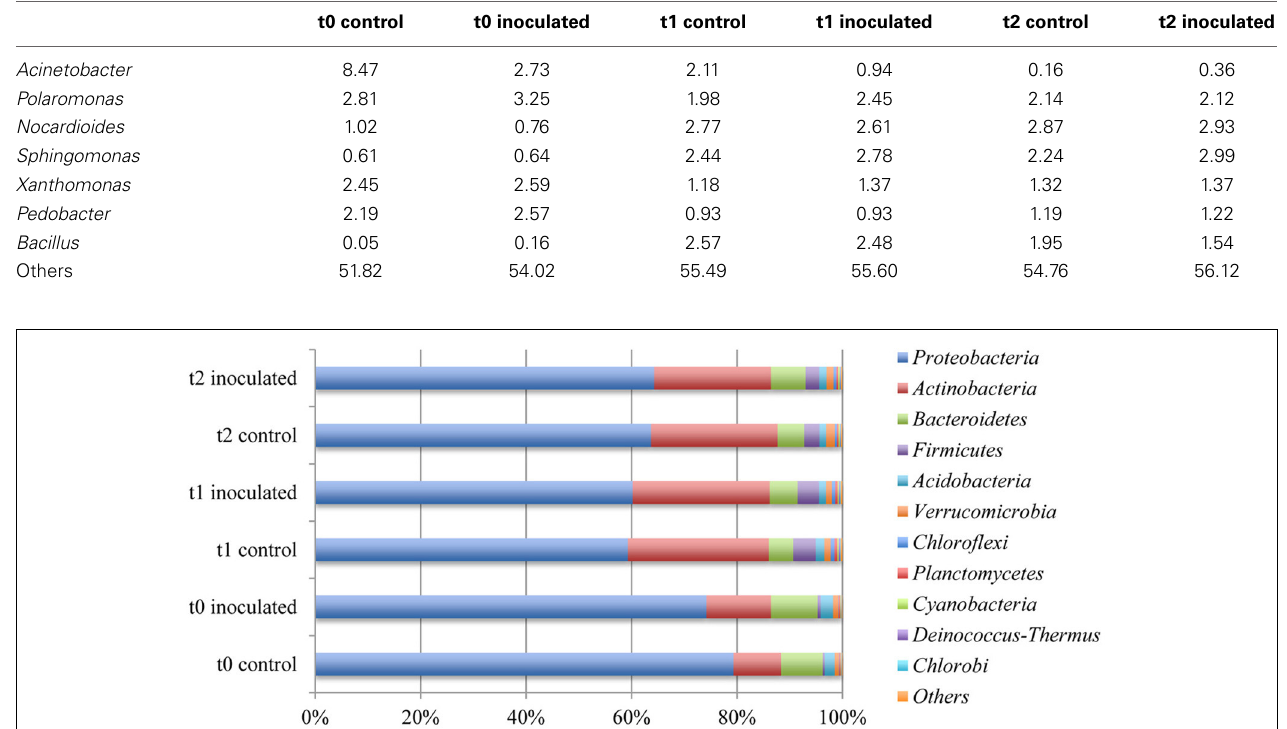
of annotated Actinobacteria increased noticeably from between 9 and 12% to around 24.8% in average in the samples drawn after 2 and 5 weeks. The relative abundances of annotated Gammaproteobacteria varied between the t0 samples between 24% in the control and 17% in the inoculated samples. Within the samples taken after 2 and 5 weeks of cultivation in the field the ratio of Gammaproteobacteria was around